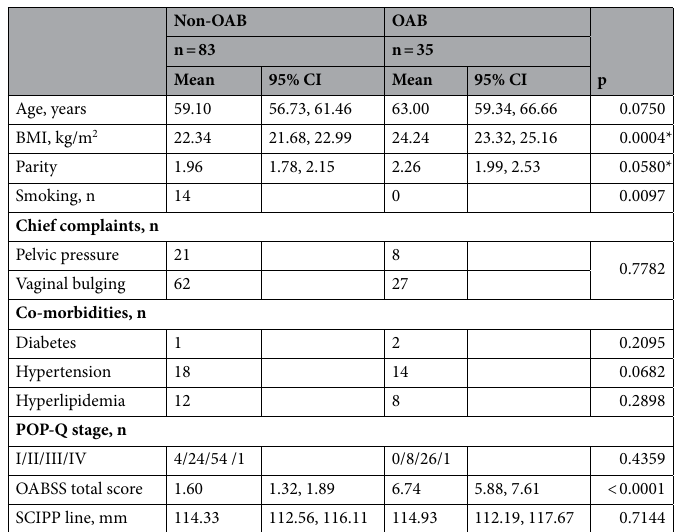
Table 1. Characteristics of patients with or without overactive bladder (OAB). The p-value for numerical variables was calculated by Student’s t-test except the p-values with a superscript (*), for which the Wilcoxon rank sum test was used. BMI, body mass index; CI, confidence interval; OABSS, overactive bladder symptom score; POP-Q, pelvic organ prolapse quantification system; SCIPP, sacrococcygeal inferior pubic